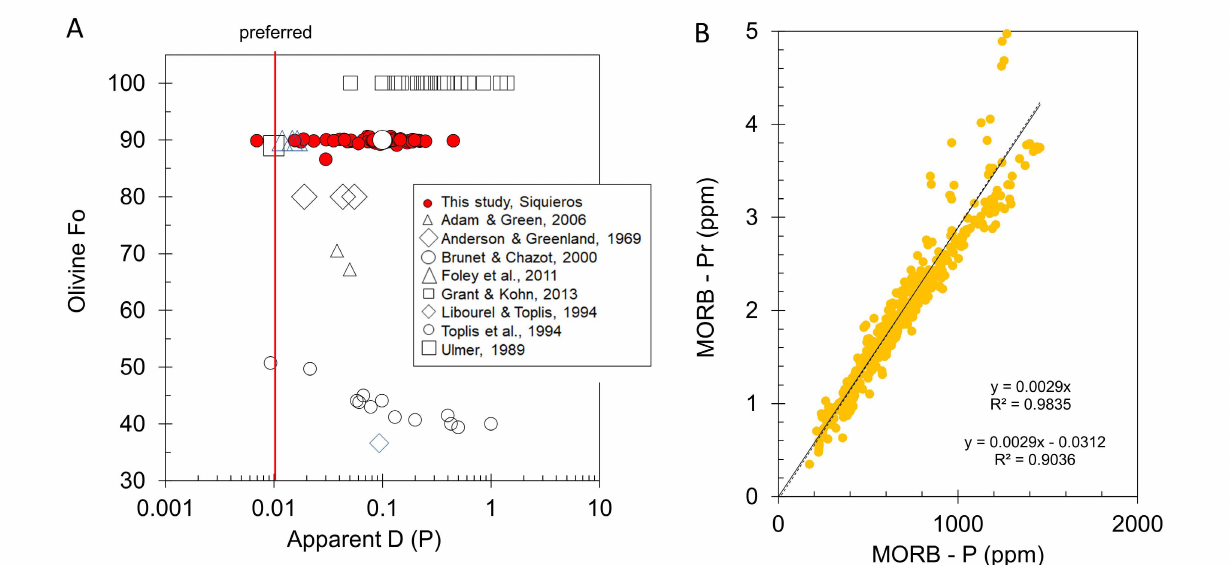
Figure 5: Constraints on P partitioning in olivine. [A] Apparent olivine/melt partition coefficients from Siqueiros MORB (this study), where natural olivine P content in olivine is divided by glass P content (red symbols). All other symbols represent es- timates of olivine/melt partitioning from experiments or natural phenocryst/magma pairs. Data sources in legend and text. Vertical red line denotes preferred olivine/melt partition coefficient (see text). References for partition coefficients from the literature are in the text. [B] P (ppm by metal) versus Pr (ppm by metal) in mid-ocean ridge basalt (MORB) glass [Jenner and O’Neill 2012]. Data were linearly regressed. Regression parameters for a regression forced and unforced through the origin are shown. The fact that the regression is indistinguishable from one that is forced through the origin indicates that bulk partitioning of P during mantle melting is identical to that of